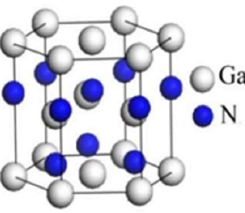
Figure 2. Gallium nitride wurtzite structure [18]. (Data from [18]).